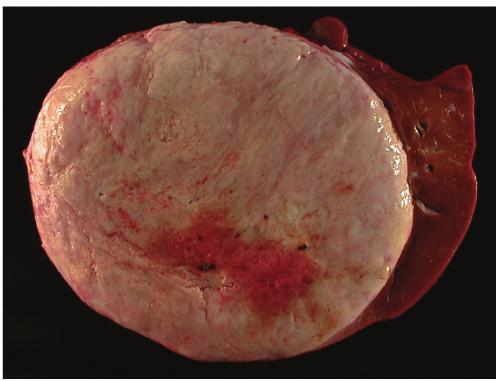
Figure 1: Gross appearance of tumor in the explant, tumor mass occupied the majority of the left hepatic lobe.